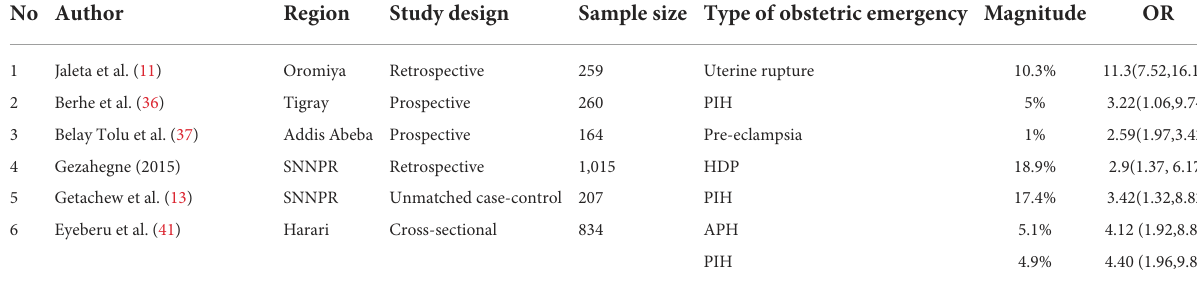
TABLE 4 Obstetric emergencies and early onset of neonatal death in Ethiopia.